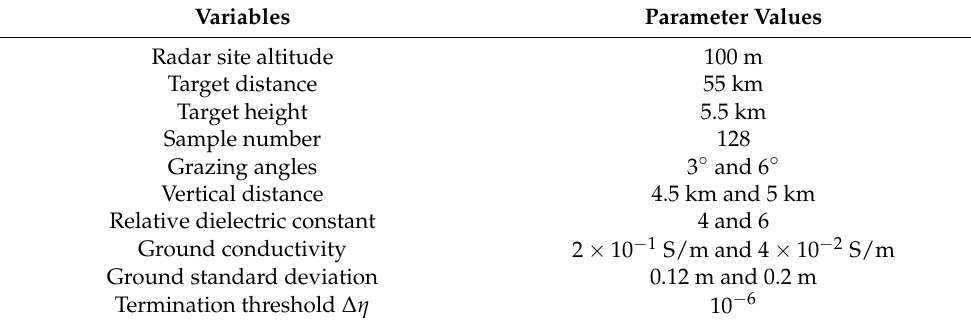
Table 2. Parameter list for the first